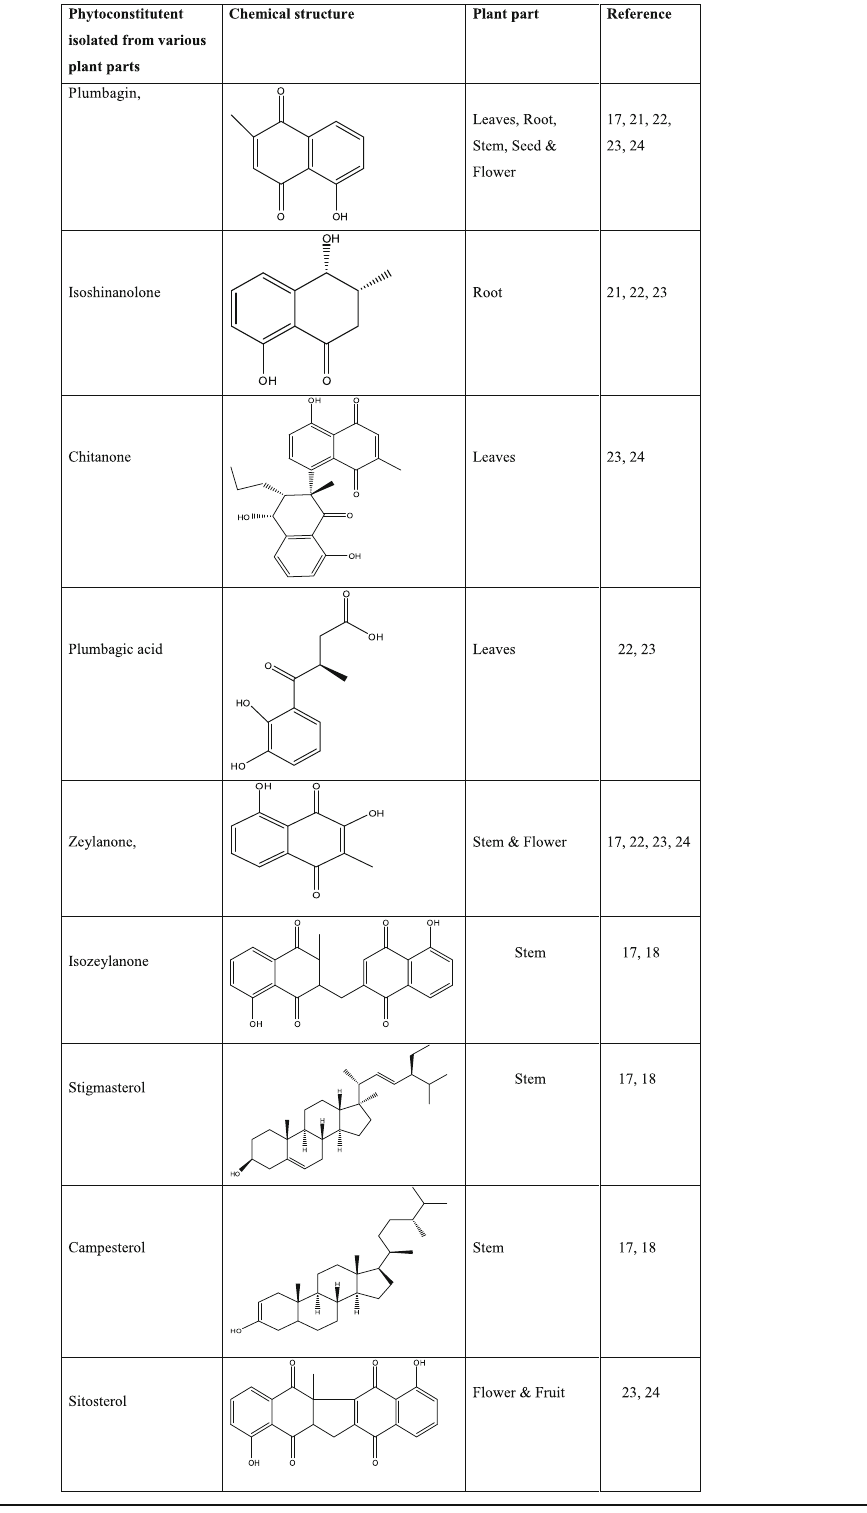
Table 1 Phytoconstituents present in different plant parts and their